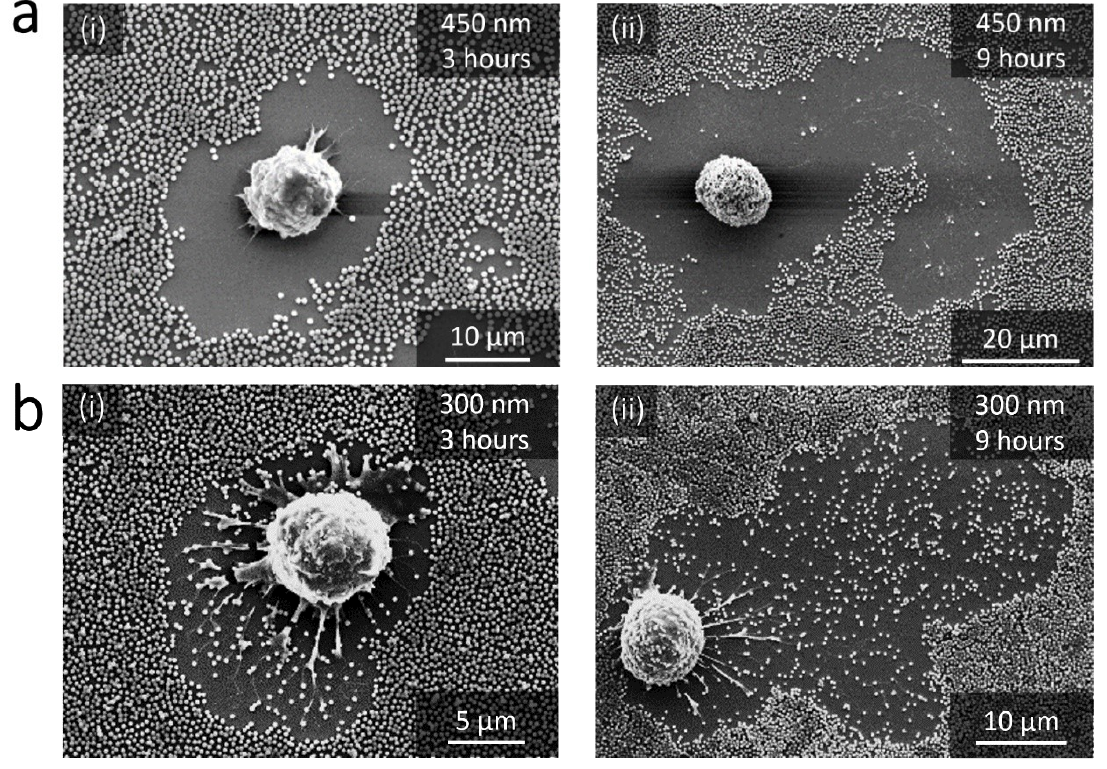
Figure 2. SEM images of macrophages adhering to substrates decorated with 450 nm and 300 nm NPs. ( a ) 450 nm silica NPs after 3 h of incubation (i) and 9 h of incubation (ii). ( b ) 300 nm silica NPs after 3 h of incubation (i) and 9 h of incubation (ii).